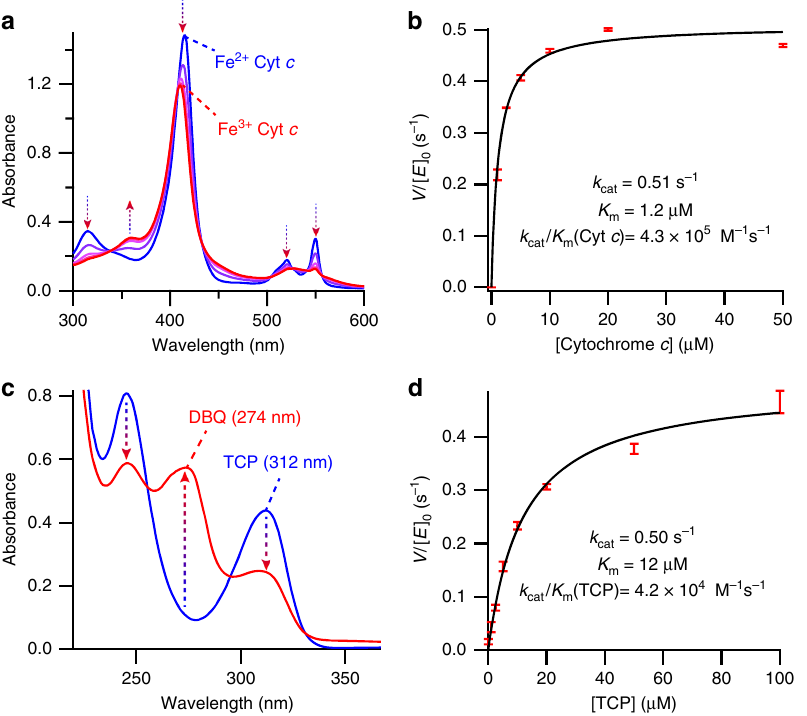
Fig. 3 Cytochrome c oxidation and TCP oxidative dehalogenation catalyzed by C45. a Representative changes to the UV/visible spectrum of equine cytochrome c during C45-catalyzed oxidation. b Michaelis – Menten plot of equine cytochrome c oxidation catalyzed by C45 in the presence of limiting H 2 O 2 (100 μ M). c Representative changes to the UV/visible spectrum of TCP during C45-catalyzed oxidative dehalogenation to the dichloroquinone product (DBQ). d Michaelis – Menten plot of 2,4,6-trichlorophenol oxidative dehalogenation catalyzed by C45 in the presence of limiting H 2 O 2 (100 μ M). All data were recorded in triplicate and error bars represent the standard